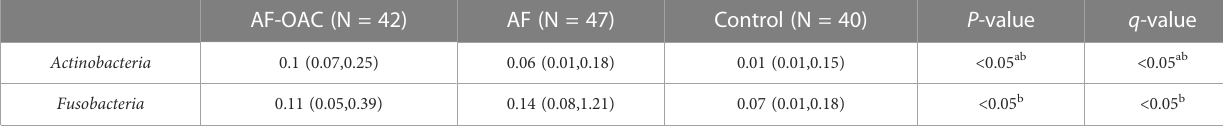
0.009 ; phylum Actinobacteria : r = 0.388 , P = 0.000 ). Genus Ruminococcus torques group and family Lachnospiraceae were relatively depleted in AF-OAC group, and their abundance showed positive correlations with NLR (species Ruminococcus